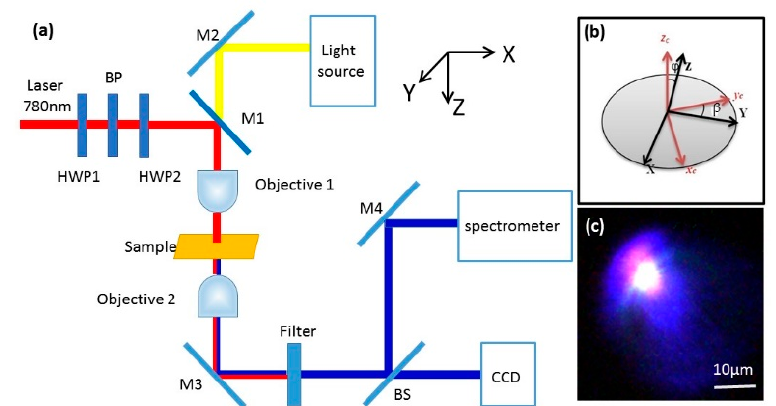
Figure 1. ( a ) Schematics of the experimental setup for measuring second-harmonic generation (SHG) signals; ( b ) geometry of the lab frame ( X , Y , Z ) and the crystal frame ( x c , y c , z c ). While, ϕ is the angle between the z c axis and the Z axis, β is the angle between the Y axis and the y c axis on the xy plane; ( c ) optical microscope image of the SHG of the ZnO film.